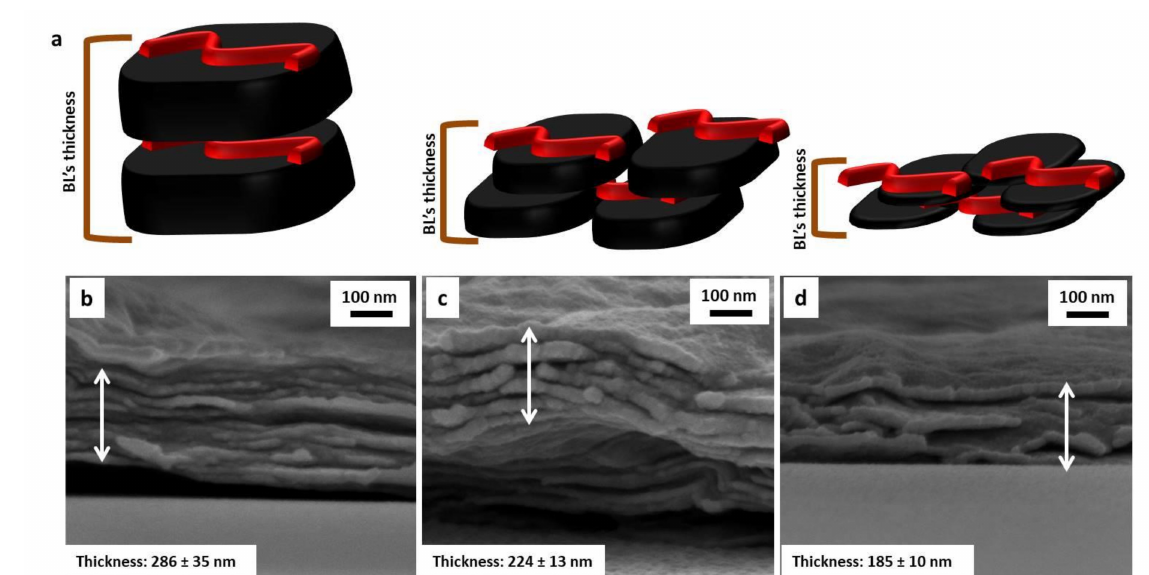
Figure 3. Schematic representation of 1BL CHIT/GO A (left), 1BL CHIT/GO B (center) and 1BL CHIT/GO C (right) thickness ( a ). FESEM micrograph of 10BL CHIT/GO A ( b ), 10BL CHIT/GO B ( c ), and 10BL CHIT/GO C ( d ) coatings on Si wafer